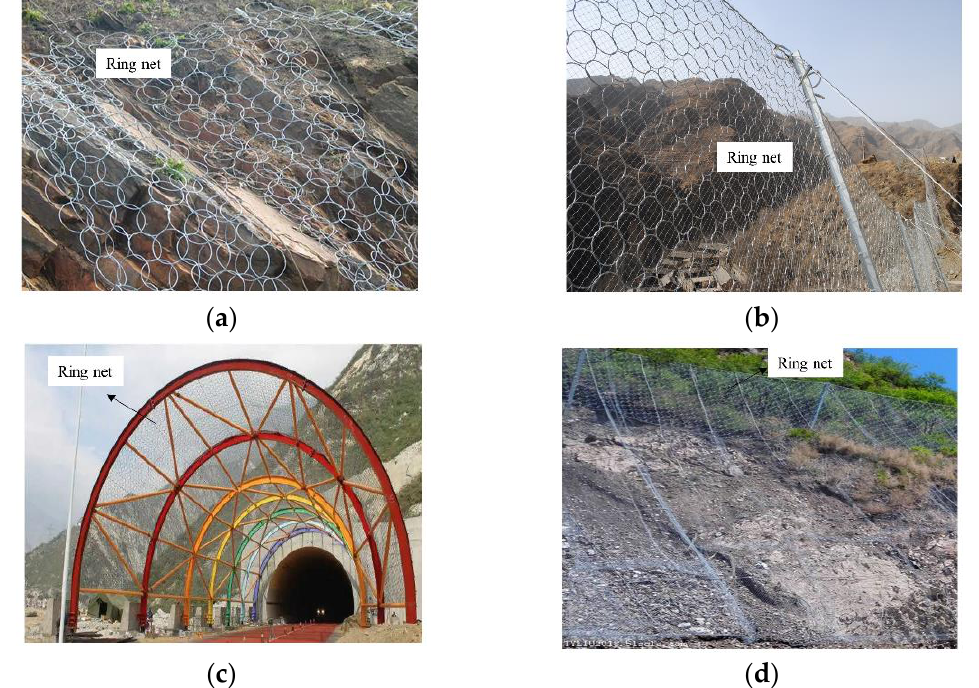
Figure 1. Ring net applications: ( a ) active flexible protection structure; ( b ) passive flexible protection structure; ( c ) flexible rock-shed; ( d ) guided flexible protection structure.